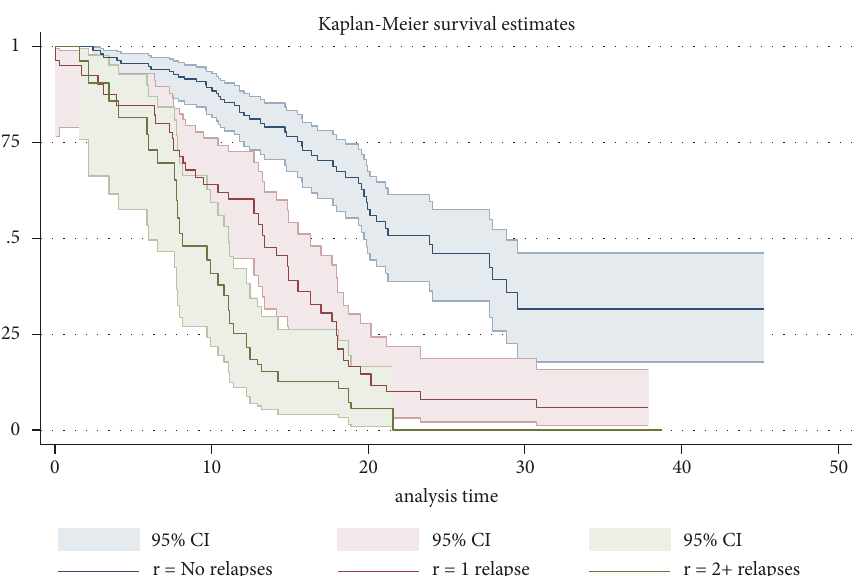
Figure 3: Progression to EDSS 4 by number of relapses (N=311). The analysis includes all 311 patients with an EDSS < 4 at baseline, regardless of treatment